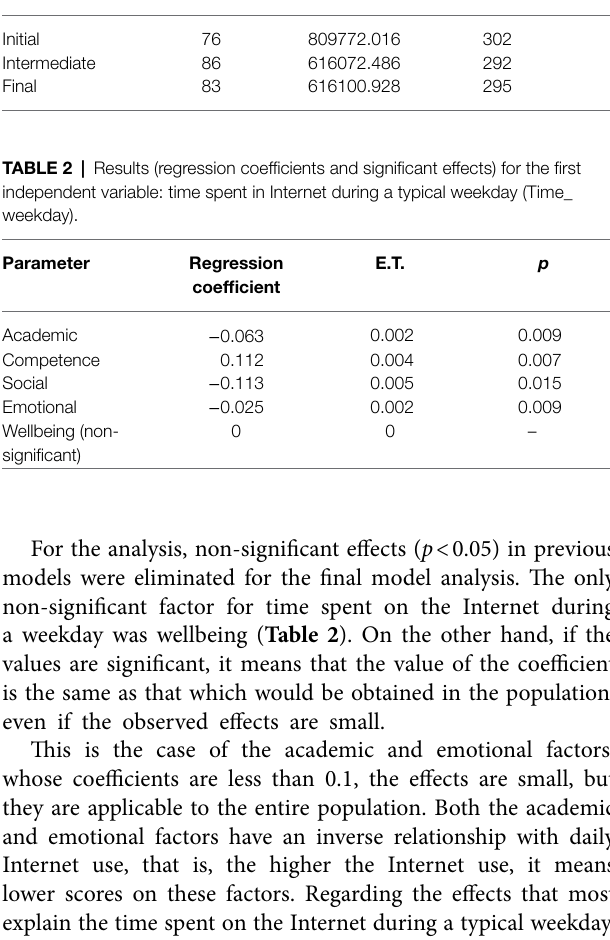
TABLE 1 | Fit indices for the three models. Model